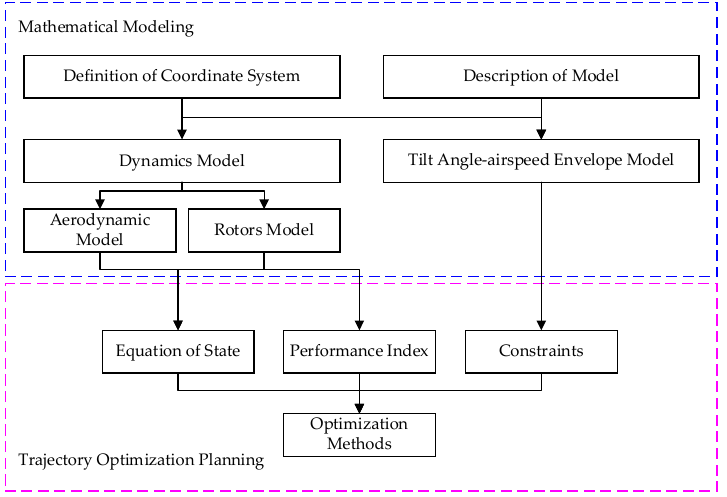
Figure 2. The structure of mathematical modeling framework.